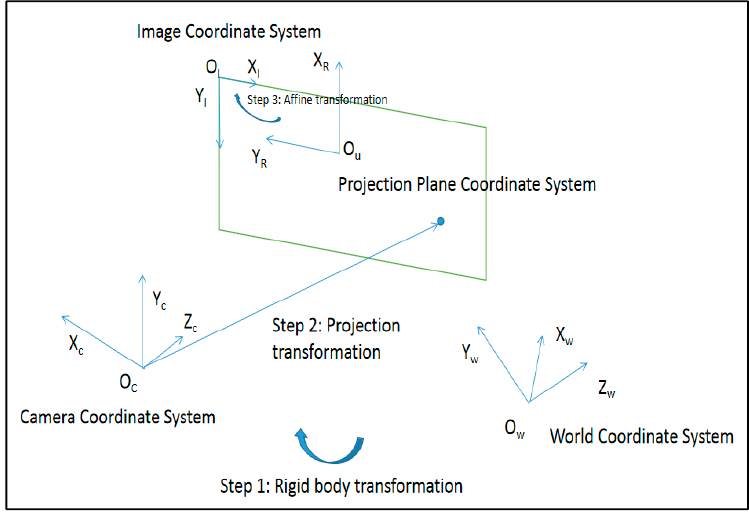
Figure 1. The transformation diagram of a coordinate system.